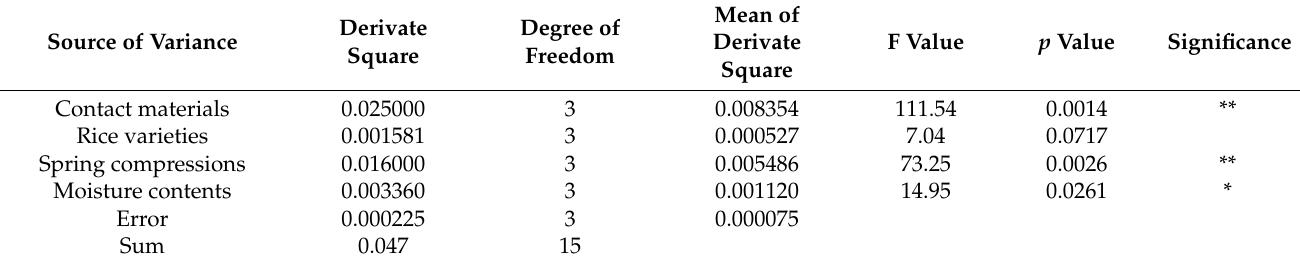
Table 5. Analysis of variance of orthogonal test for restitution